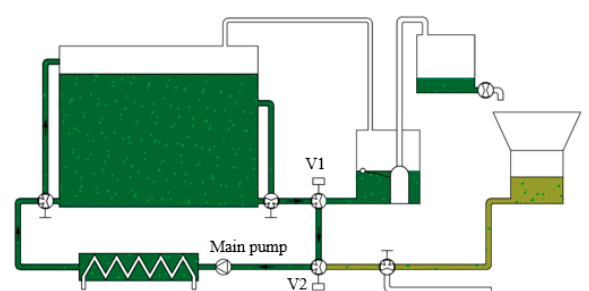
Figure 4. Schematic representation of reactor liqueur circulation when the mixing-heating configuration is activated.